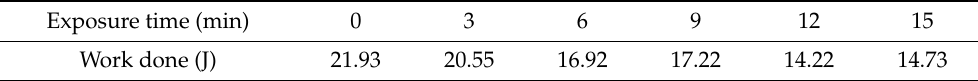
Table 5. The work done by the driving force at different microwave exposure times.